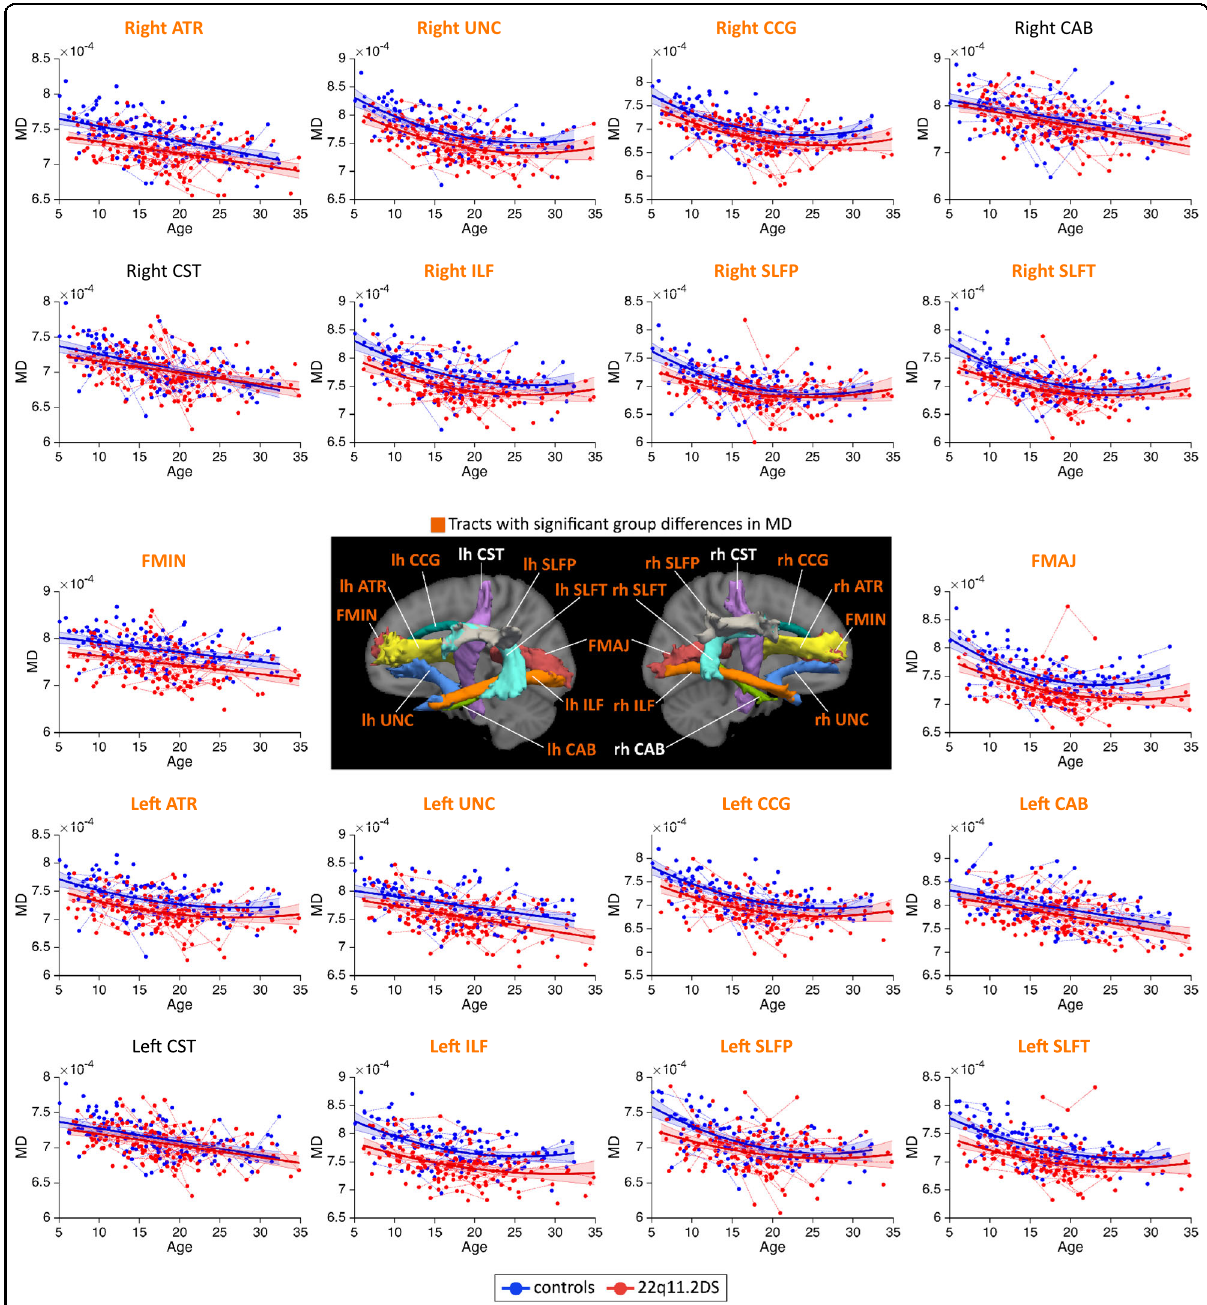
Fig. 1 Developmental trajectories of mean diffusivity (MD) in patients with 22q11.2DS and controls. MD metrics followed linear or quadratic decreasing trajectories in 22q11.2DS (red) and controls (blue). No signi fi cant age × group interaction effects were found, indicating that patients with 22q11.2DS and controls followed parallel developmental curves with similar shapes. However, signi fi cant group differences were found in MD, with systematic reductions in individuals with 22q11.2DS for most white matter tracts. Tracts with signi fi cant group differences are highlighted in orange in plot titles and in the central fi gure. For a summary of all p -values for group and age × group interaction effects in white matter tracts, see Supplementary Materials, Table S4. The signi fi cance threshold was set at p < 0.05. All results were corrected for multiple comparisons using the FDR method. lh left hemisphere, rh right hemisphere, FMAJ forceps major (corpus callosum), FMIN forceps minor (corpus callosum), ATR anterior thalamic radiation, CAB cingulum – angular bundle, CCG cingulum – cingulate bundle, CST corticospinal tract, ILF inferior longitudinal fasciculus, SLFP superior longitudinal fasciculus – parietal bundle, SLFT superior longitudinal fasciculus – temporal bundle, UNC uncinate